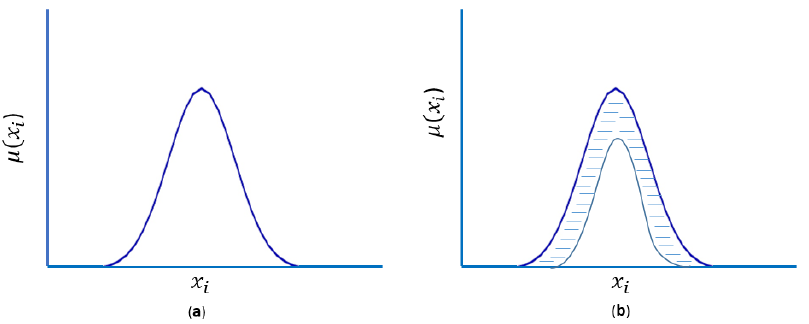
Figure 2. The membership function representation: ( a ) Type-1 fuzzy membership function; ( b ) type-2 fuzzy membership function.